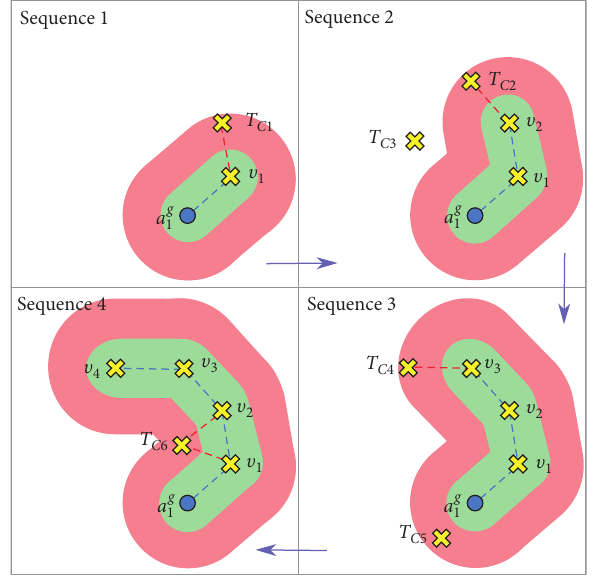
Figure 5: An example of multitask planning by a gatherer